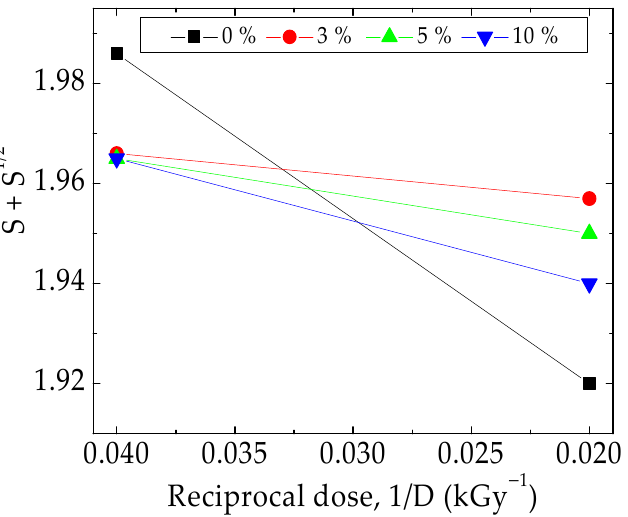
Figure 8. Charlesby – Pinner representation of radiation effects in PLA/SIS 30/SiO 2 hybrids. Figure 8. Charlesby–Pinner representation of radiation effects in PLA/SIS 30/SiO 2